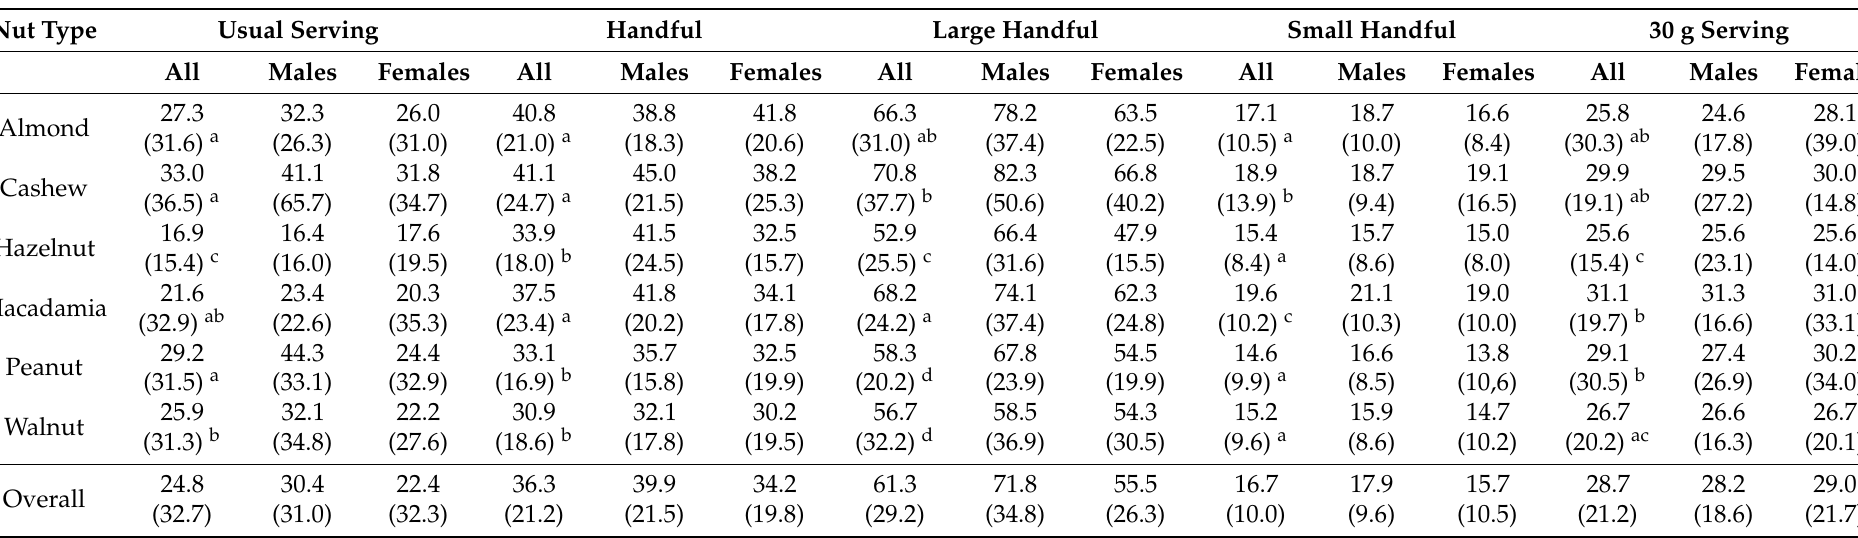
Table 2. Median (IQR) quantity of nuts in grams selected for the different portion